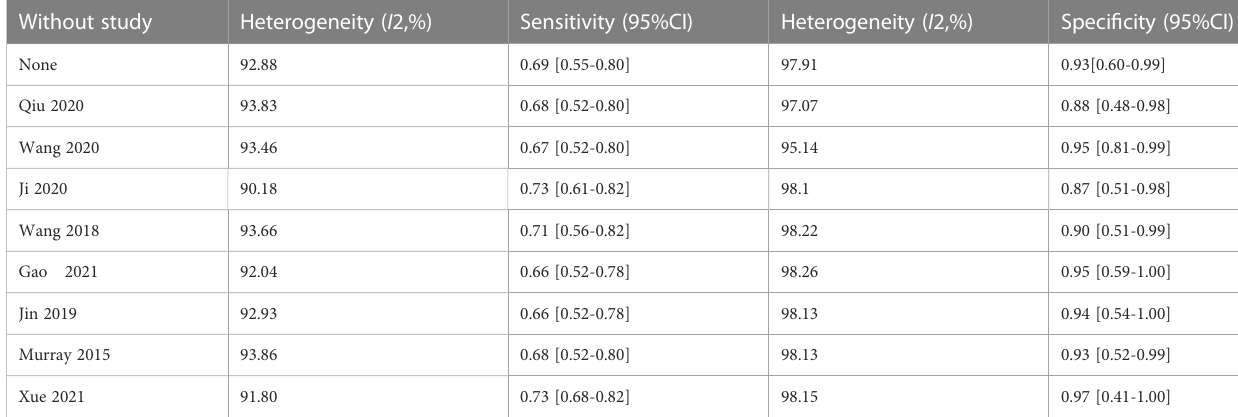
TABLE 3 Meta-analysis sensitivity analysis for included